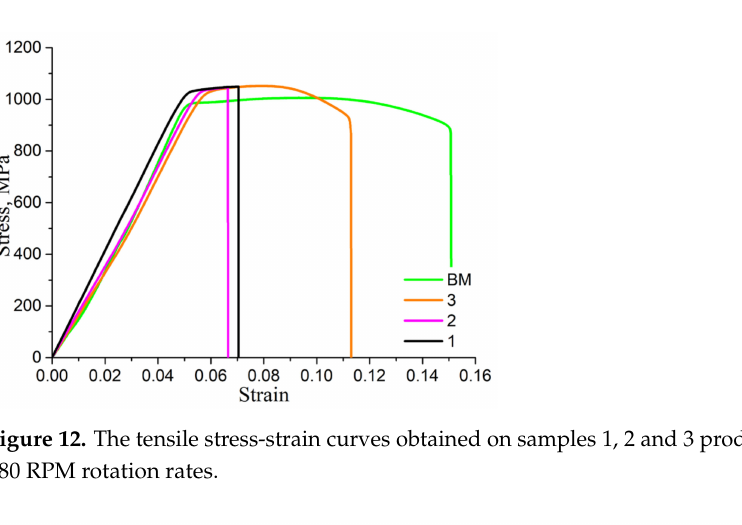
Figure 11. Microhardness of the welded joint Ti-6Al-4V alloy obtained by friction stir welding with nickel-base heat-resistant tool along the green lines shown in Figure 7: ( a ) vertical profile; ( b ) horizontal profile.